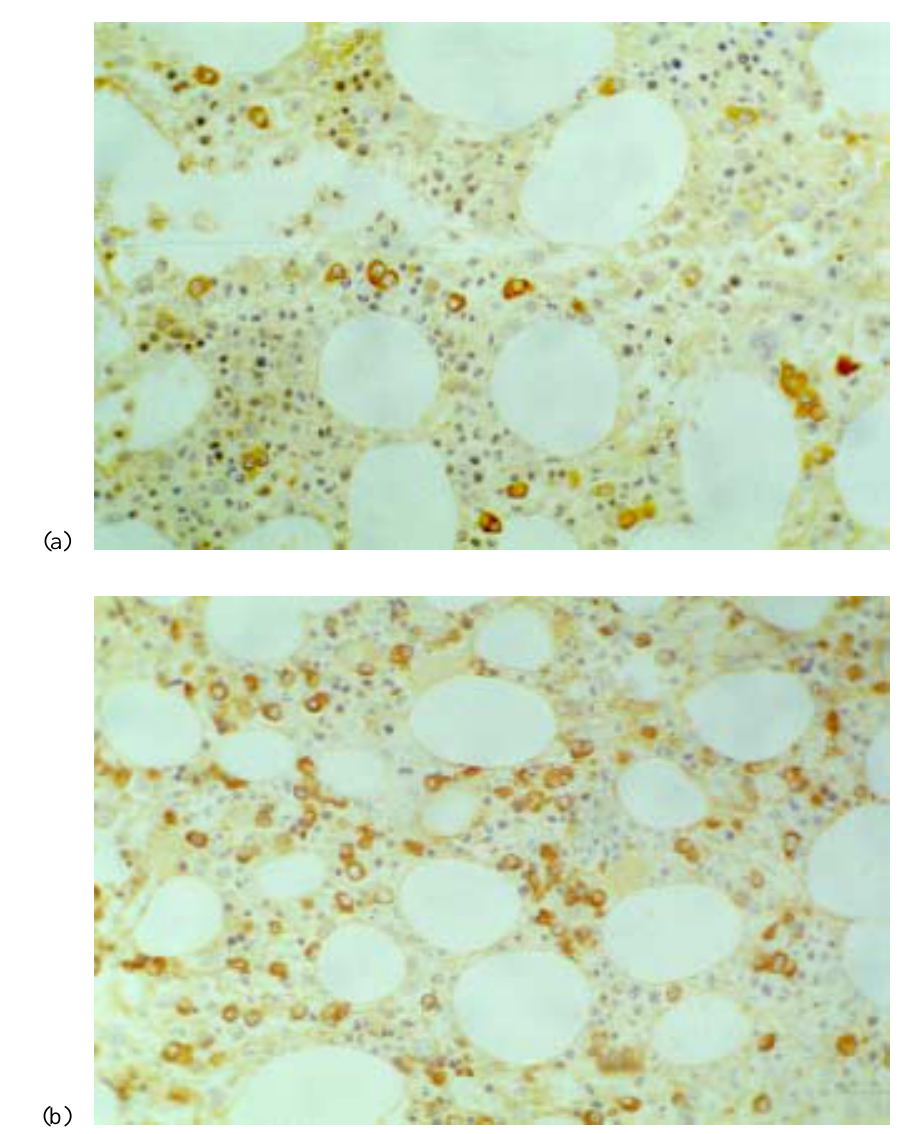
Fig. 2. Photomicrographs of immunostained sections comparing the monoclonal populations of two patients each of whom had 9% plasma cells in their aspirated samples. Patient a – 130/mm 2 and Patient b – 908/mm 2 . This figure can be viewed on http://www.esacp.org/acp/2003/